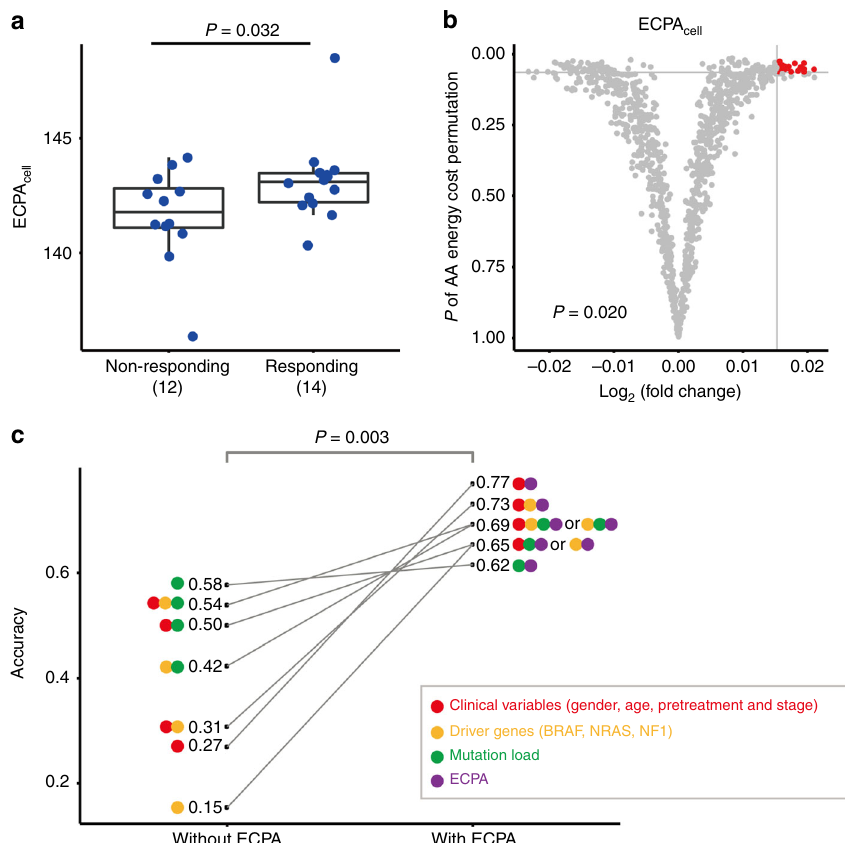
Fig. 7 The predictive power of ECPA cell for response to anti-PD-1 immunotherapy. a Comparison of ECPA cell between responding (14 patients) and non- responding (12 patients) groups diagnosed with melanoma. One-sided t- test P -value is shown. Center line, median; box limits, upper and lower quartiles; whiskers, 1.5 times the interquartile range. b Volcano plots showing how P -values and ECPA cell differences (responding/non-responding) for the two-group comparison of ECPA cell are distributed given 1000 permutations, where the biosynthetic energy costs of 20 AAs were randomly shuf fl ed. The gray horizontal and vertical lines indicate the P -value and the fold-change observed from the true ECPA cell . The red dots falling in the upper-right corner of the gray lines represent random cases that are better than the true values shown in a . Empirical P -value ( P = 0.02) was estimated using the number of red dots divided by the total number of permutation tests. c Comparison of predictive power between the models with and without ECPA cell using random forests with leave-one-out cross-validation. In addition to ECPA cell (purple circle), three groups of candidate features were used: clinical variables (red circle), mutation status of melanoma driver genes (yellow circle) and mutation load (green circle). The P -value (0.003) was calculated by paired t -test between the models with and without ECPA cell as the candidate feature. The paired models are linked by the solid gray